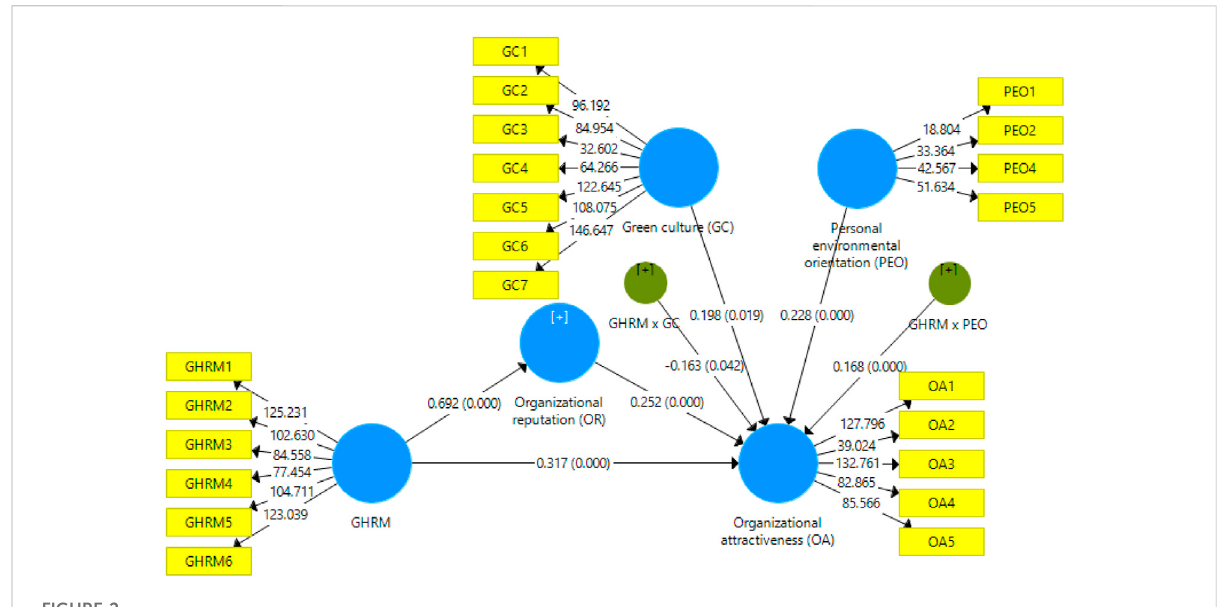
FIGURE 2 Structural equation modeling.